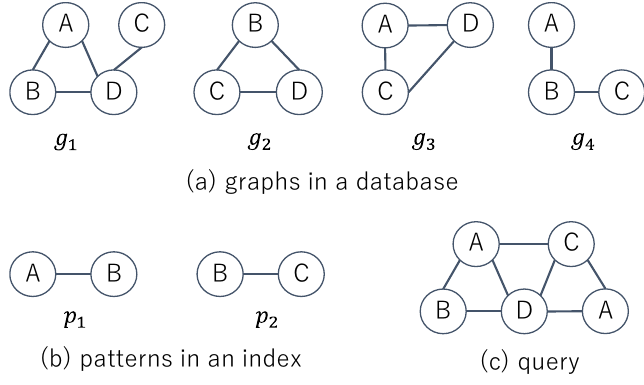
Figure 2. Example of supergraph